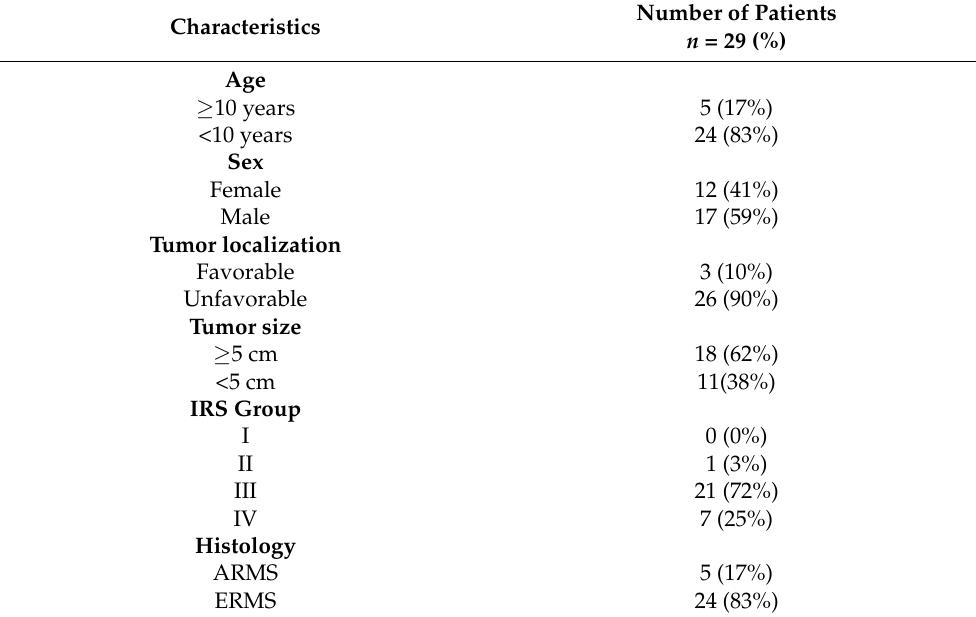
Table 1. Patient’s characteristics. Favorable localization: head and neck non-parameningeal, vagina, paratesticular; Unfavorable localization: extremities, trunk, bladder/prostate, perianal; IRS: In- tergroup Rhabdomysarcoma Study; IRS I: macroscopically and microscopically complete tumor resection; IRS II: macroscopically complete tumor resection with microscopic residuals; IRS III: macroscopic residuals or